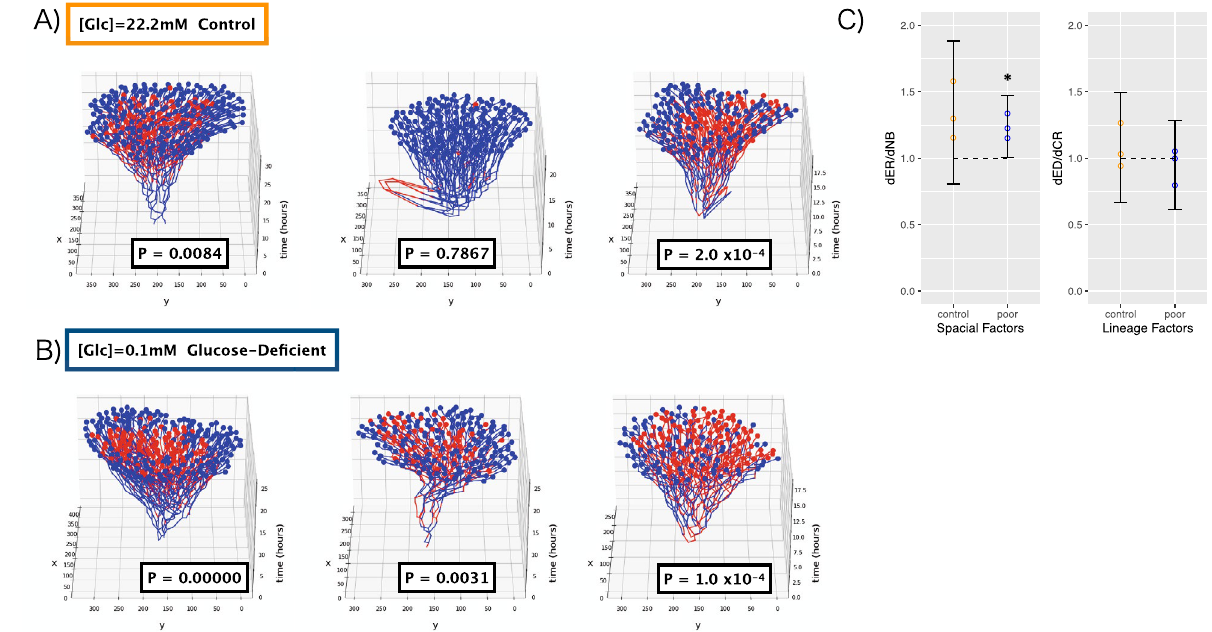
Figure 3. Spatial correlation within lineages grown under glucose-deficient conditions. Three-dimensional cellular lineages of E. coli acquired under ( A ) control conditions (22.2 mM glucose) and ( B ) glucose-deficient conditions (0.1 mM glucose) obtained by triplicate experiment. Individual E. coli cells were color-coded: red, high intracellular ATP concentration; blue, low intracellular ATP concentration. Individual P values for spatial localization are shown. ( C ) Effects that contribute to spatial localization 28 of ATP classes. By quantifying the average difference in phenotype among cells closest to a specific individual cell (dNB) and the sister cell of that closest cell (dER), we assessed whether spatial proximity contributed to spatial correlation (dER/dNB). However, for lineage factors, we measured the average difference in phenotype between the closest relative of each individual cell (dCR) and a cell at an equidistant position (dED). The larger the phenotypic difference of the cell at an equidistant position, the stronger the effect of lineage in promoting spatial correlation. The error bar shows the 95% confidence interval in a t -distribution. *, P < 0.05; H0, dER/dNB = 1 or dED/dCR =